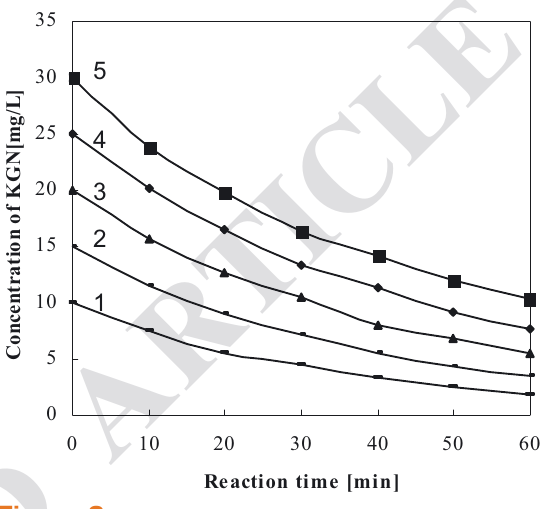
Figure 2. Plot of photo-degradation of KGN vs. irradiation time (1) 10 mg L −1 (2) 15 mg L −1 (3) 20 mg L −1 , (4) 25 mg L −1 (5) 30 mg L −1 .